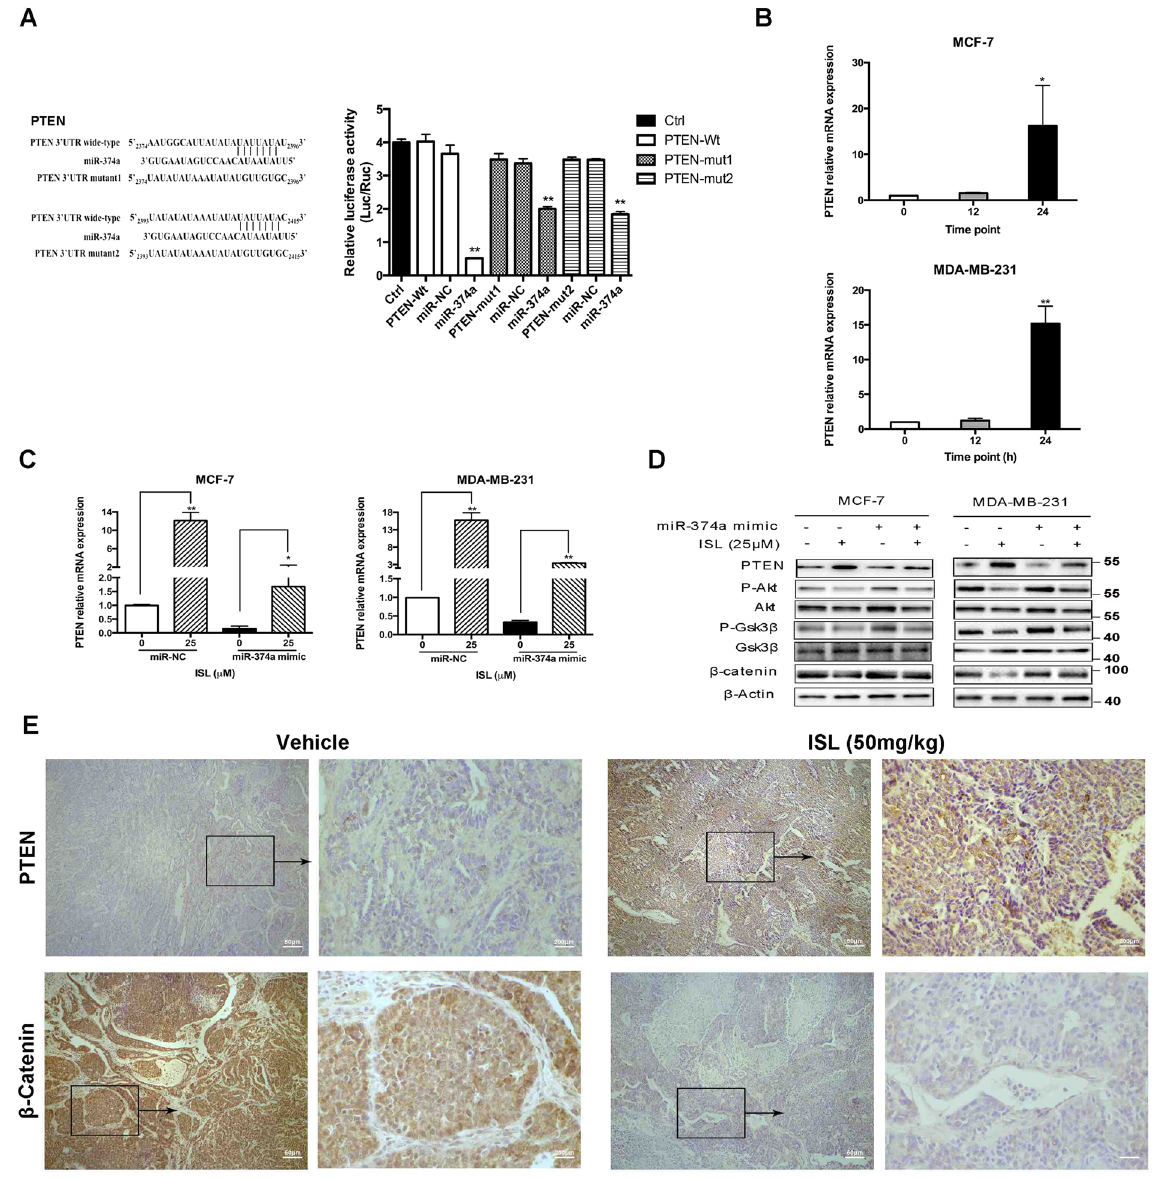
Figure 6. MiR-374a/PTEN/Akt axis is involved in ISL inhibition of breast cancer. ( A ) Dual luciferase reporter assay analysis of the effect of miR-374a expression on 3’UTR of PTEN in 293 T cells. ( B ) qRT-PCR analysis of miR-374a targeted gene expression at the indicated time points in the presence of ISL. ( C ) qRT-PCR analysis of PTEN mRNA expression in normal and miR-374a-overexperssing breast cancer cells interfered with ISL. ( D ) Western blot analysis of miR-374a function on PTEN up-regulation, Akt inhibition, GSK3 β suppression, and β -catenin down-regulation by ISL. The full-length blots were presented in the Supplementary Fig. 9. ( E ) Representative images of IHC analysis of PTEN and β -catenin expression in vehicle and ISL-treated